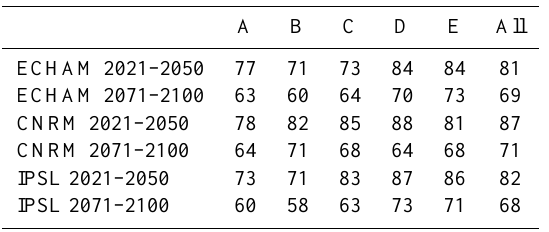
Table 5. Similarity index (SI) for the near (2021–2050) and far (2071–2100) future, compared to the control period (1971–2000) derived from a conceptual hydrological model forced with three GCMs. SI is given for all major climates: Equatorial (A), Arid (B), Warm temperate (C), Snow (D) and Polar climates (E), and aver- aged over all